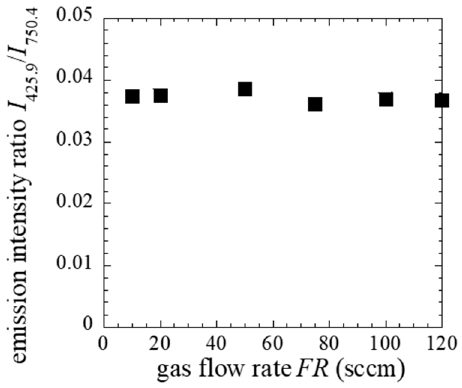
Figure 8. Dependence of I 425.9 / I 750.4 on FR.